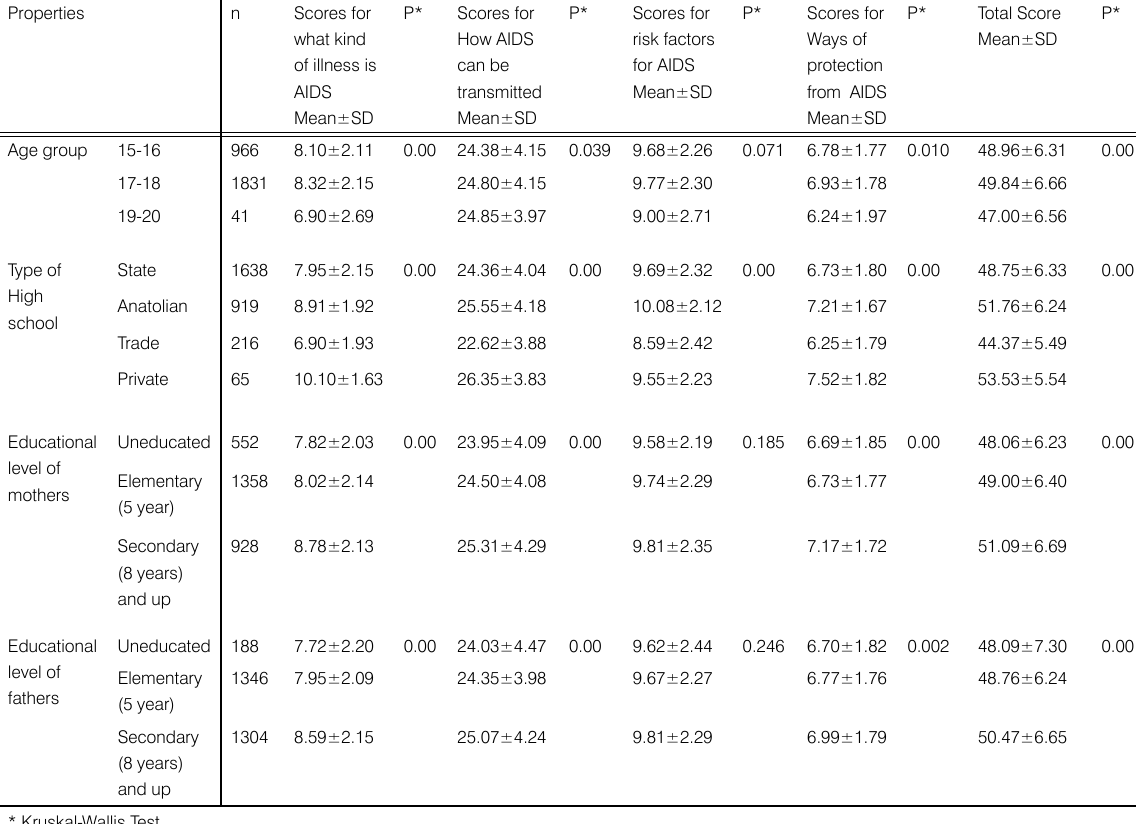
Table 2 Knowledge levels of students about AIDS with respect of their socio-demographic properties Properties